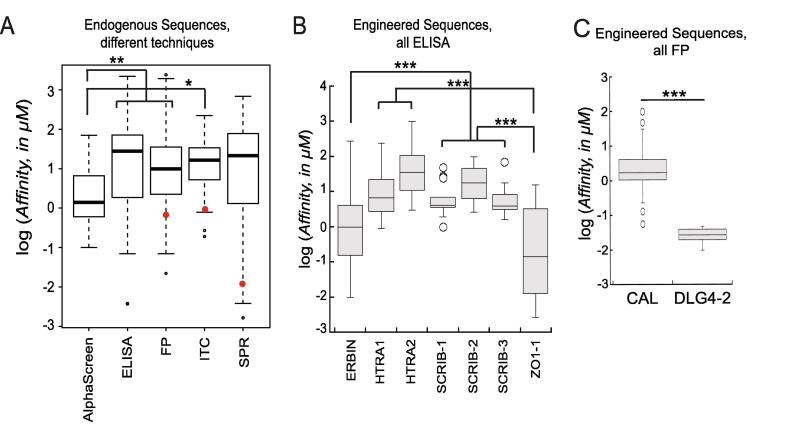
Binding affinities analyzed by experimental technique (A) and domain identity (B–C). (A) We compiled a sampling of previously reported binding affinities for sequences derived from endogenous binding partners (Table S4), measured using a variety of techniques (e.g., FP, SPR, ITC). Statistical comparisons reveal a difference in affinity estimates associated with AlphaScreen compared to the other techniques. Avidity effects can affect measurements using non-solution-based techniques, such as AlphaScreen, but also ELISA and SPR, depending on how the experiment is performed. For example, affinity values were estimated in parallel using different techniques for NHERF1-1 binding to CFTR and are marked with red circles on the FP (KD = 597 nM), ITC (KD = 787 nM), and SPR (KD = 10.3 nM) bars. (B, C) Experimental binding affinities were also compiled for high affinity engineered interactors (Table S6). (B) Comparisons among sequences developed using phage display, reveal that these proteins bind to their optimized sequences with a different range of affinities. (C) Experimental binding affinities of high affinity interactors developed using fluorescence polarization (FP) analysis for the CAL and Dlg4-2 PDZ domains, also reveal a statistically significant difference in affinities. For all, * p ≤ 0.05 or ** p ≤ 0.01 by linear test (A) or *** p ≤ 0.005 by one-way ANOVA using Tukey’s HSD post-hoc test (B–C).